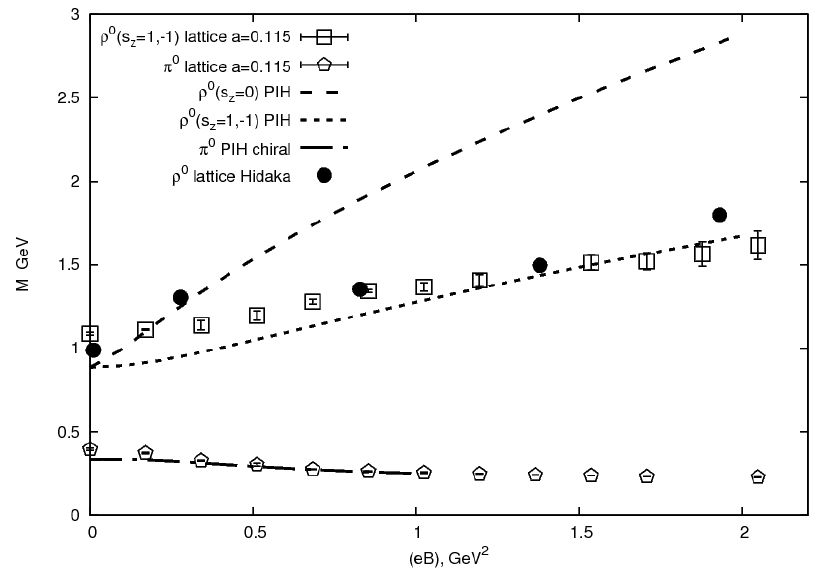
Figure 5 . Mass evolution of ( (cid:25) 0 ; (cid:26) 0 )( u (cid:22) u ) quartet in MF from analytic (PIH) and lattice data (black circles are from